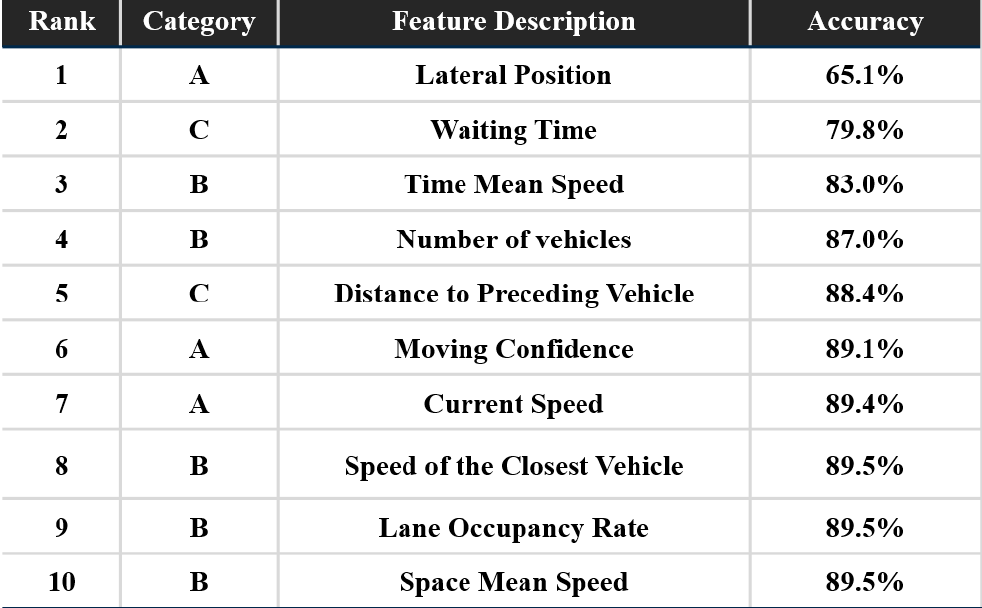
Figure 8. Results of the importance